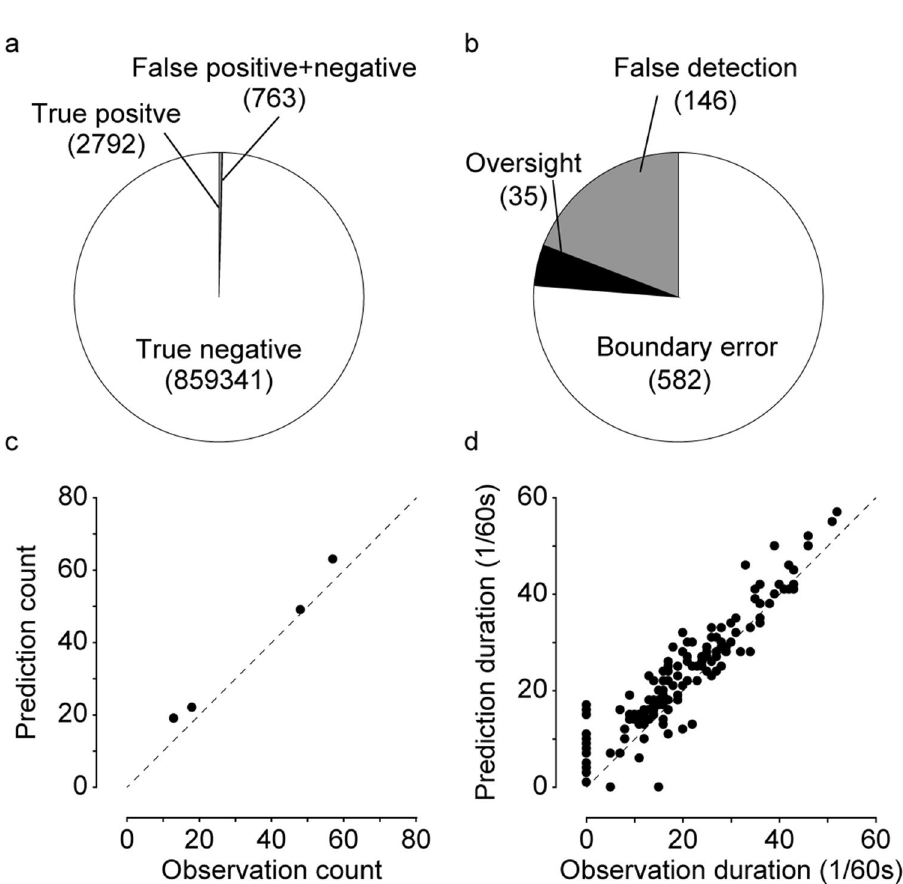
Figure 5. Application to DNFB-induced dermatitis model. ( a ) The number of true positive/negative segments and false positive/negative segments of DNFB-treated mouse video files. ( b ) The number of three errors. ( c ) The comparison of scratching counts in each video file between prediction and observation. ( d ) The comparison of duration time of each scratching event between prediction and observation. The dotted lines indicate the line when prediction was equal to